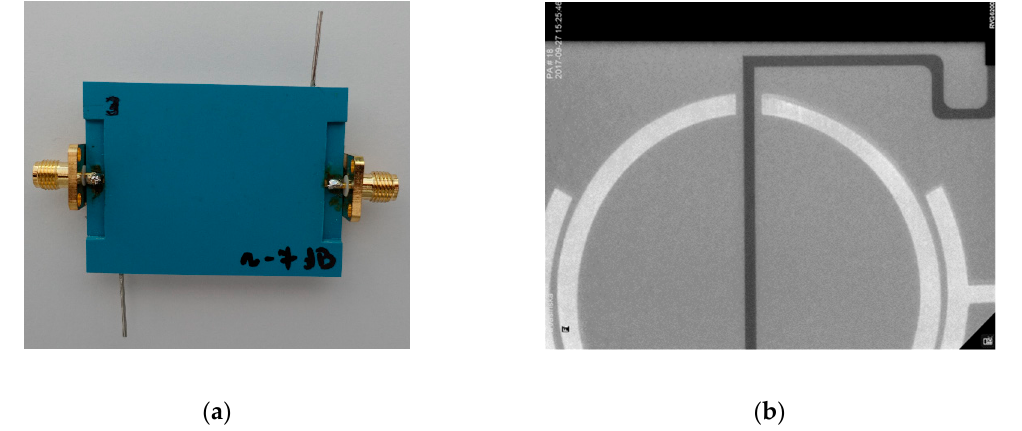
Figure 6. The resonator-based sensor: ( a ) photo, ( b ) X-ray image for a resonator and microchannel alignment.